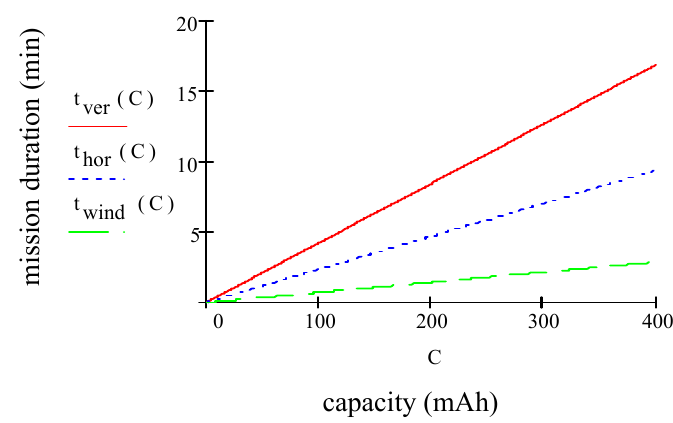
Figure 8. Mission duration vs capacity.